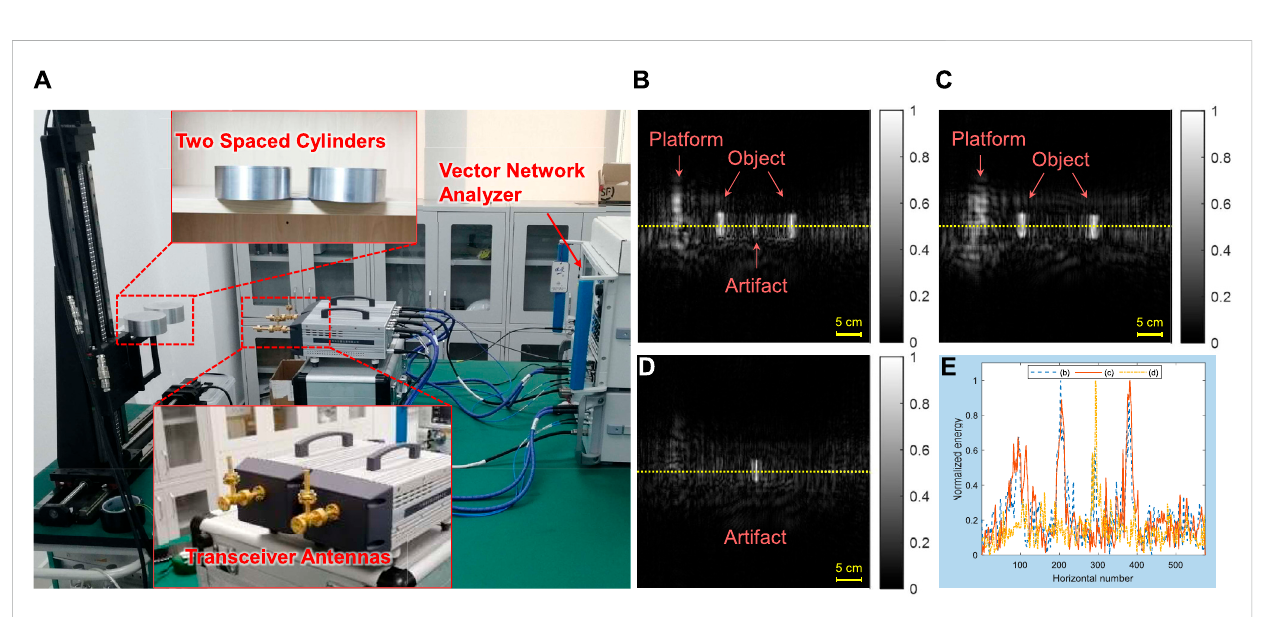
FIGURE 4 Measured imaging results of two spaced aluminum cylinders along the observation direction. (A) Measurement experiment setup of co-polarized and cross-polarized imaging for two spaced aluminum cylinders at the working frequency of 97 ~103 GHz. (B) Co-linear polarization imaging (Conventional imaging). (C) Cross-circular polarization imaging. (D) Co-circular polarization imaging. (E) Normalized pixel values of the yellow dashed line in (B) , (C) , and (D)